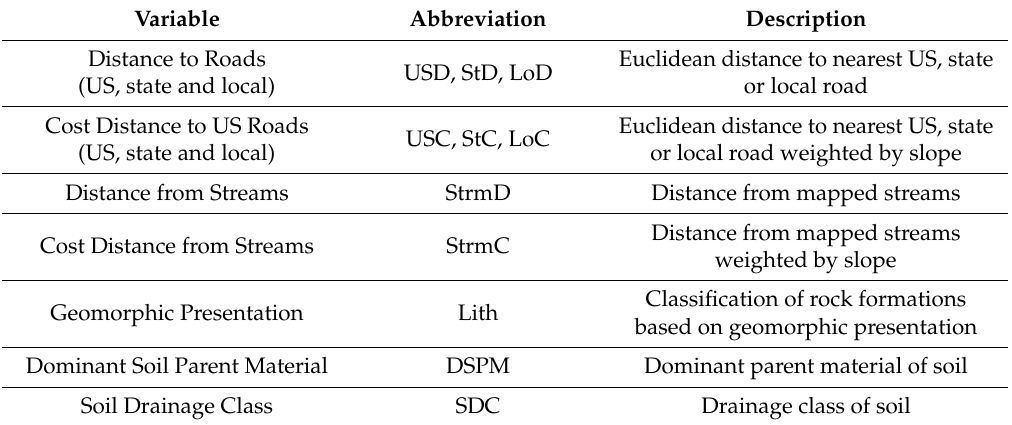
Table 3. Additional predictor variables. Abbreviations defined in this table will be used throughout the paper.